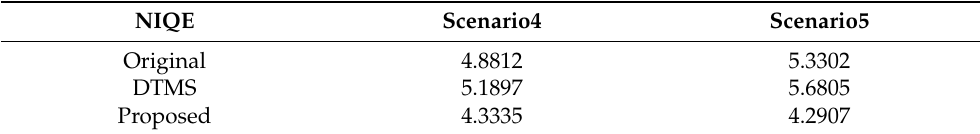
Table 2. Image quality evaluation without